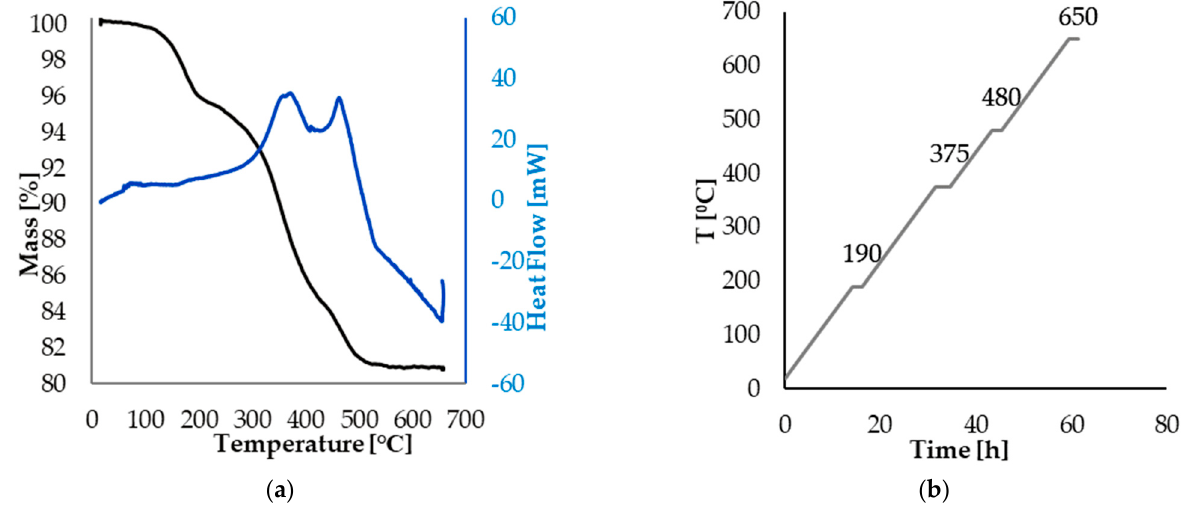
Figure 6. ( a ) TG-DSC curves of Al 2 O 3 sample. ( b ) Details of the adopted debinding cycle.